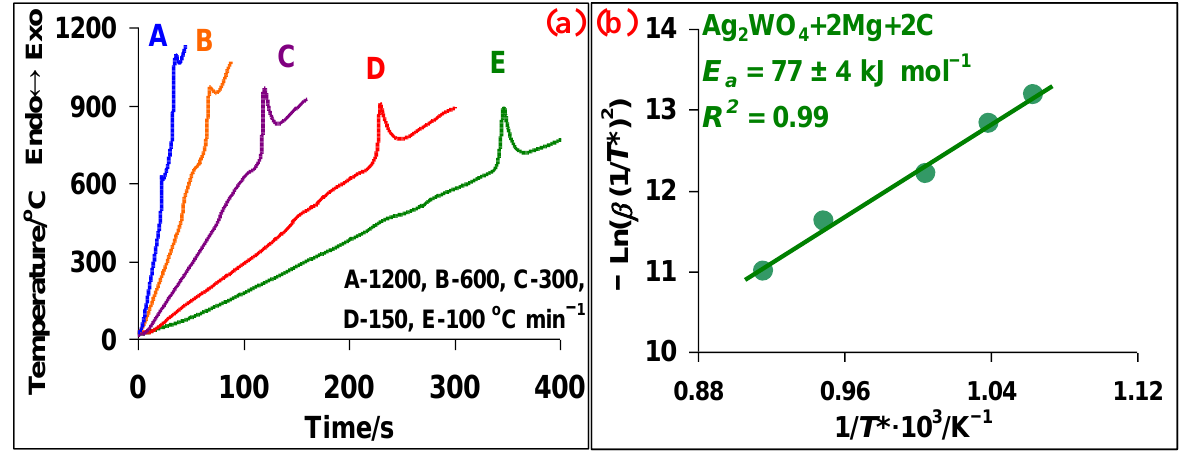
Figure 10. Heating curves of the Ag 2 WO 4 + 2Mg + 2C mixture at various heating rates, β = 100 – 1200 °C min −1 ( a ), and effective activation energy plot for the Ag 2 WO 4 + 2Mg + 2C reaction ( b ).